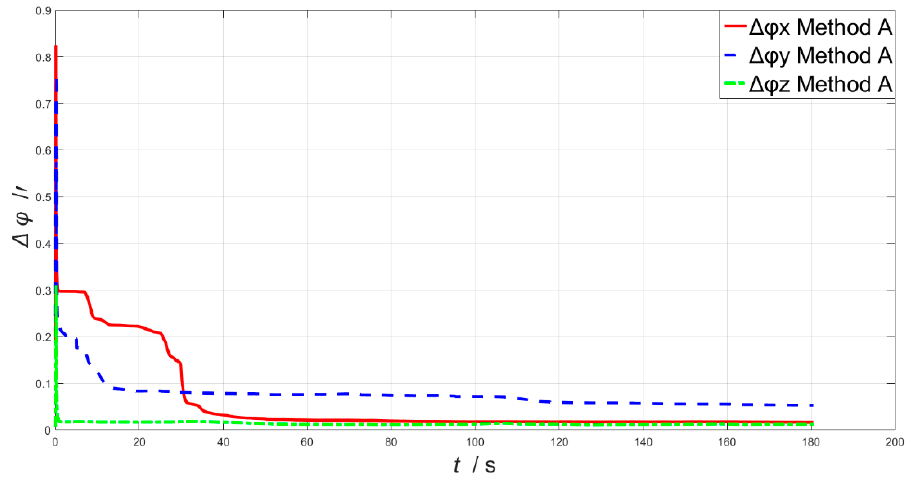
Figure 8. The estimation errors of the coupling angles.